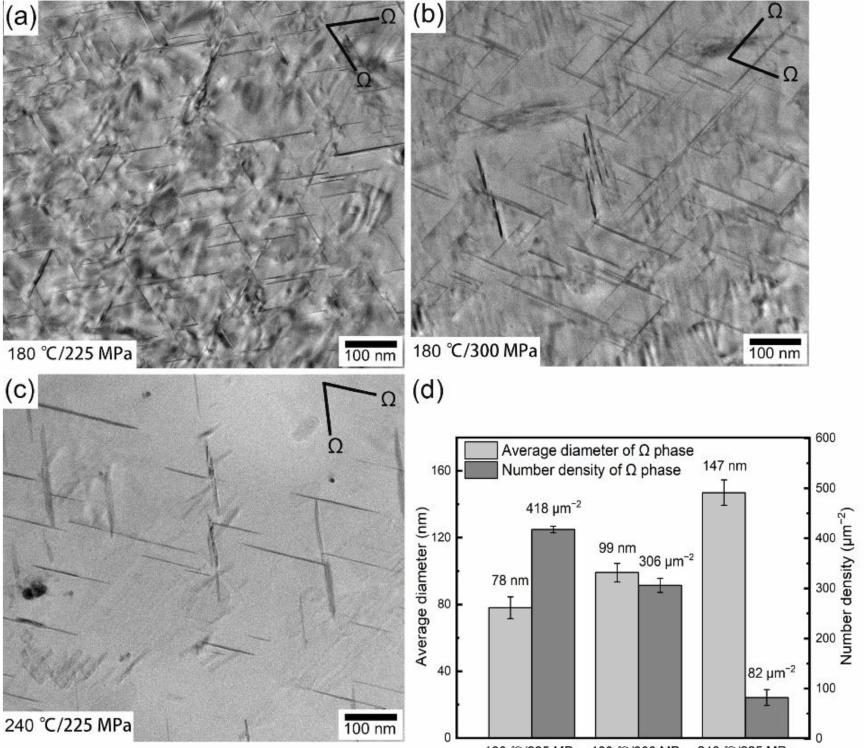
Figure 6. Bright-field TEM images of the alloy with 6.00 wt % Cu creeps under different conditions: results of the Ω phases of the alloy with 6.00 wt % Cu creeps under different